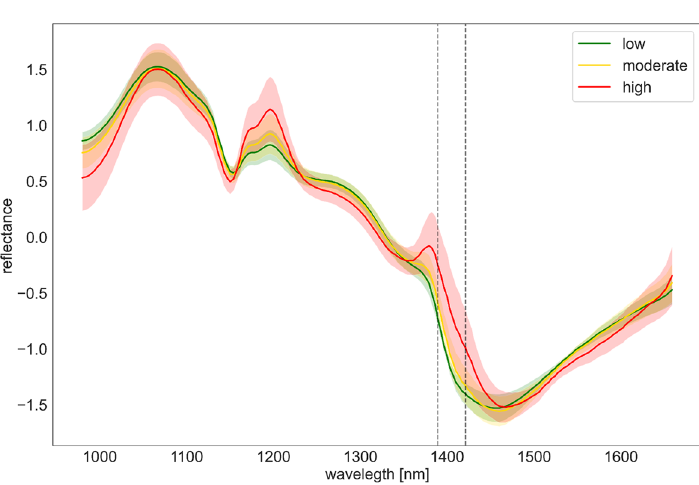
Figure 16. Mean spectral response with with standard deviations of sepals grouped into 3 categories. Two vertical lines highlight the range of 1390–1420 that model explanation identified as the most